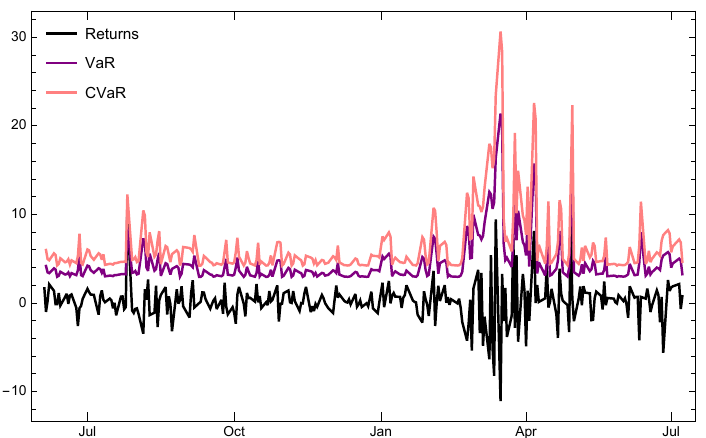
Figure 6. Results of risk comparisons (based on Laplace distribution) by the pre-determined confi- dence level α = 95% for the NASDAQ:GOOG. The horizontal and vertical axes stand for the time and risk values and returns, respectively.